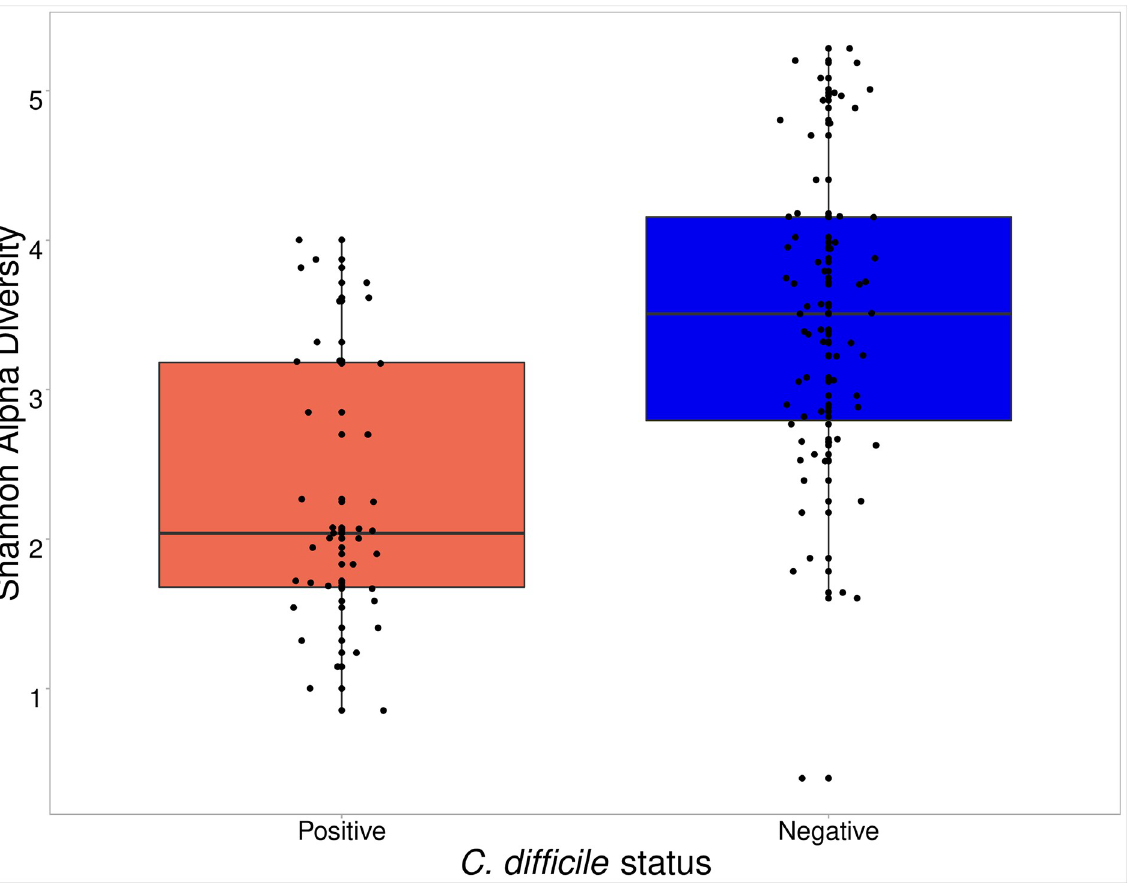
Fig 2. Boxplot of the Shannon diversity indices among C . difficile -positive puppies (left) and C . difficile -negative puppies (right). Boxes display the median, first and third quartiles, and whiskers extend to the minimum and maximum, while points represent outliers.